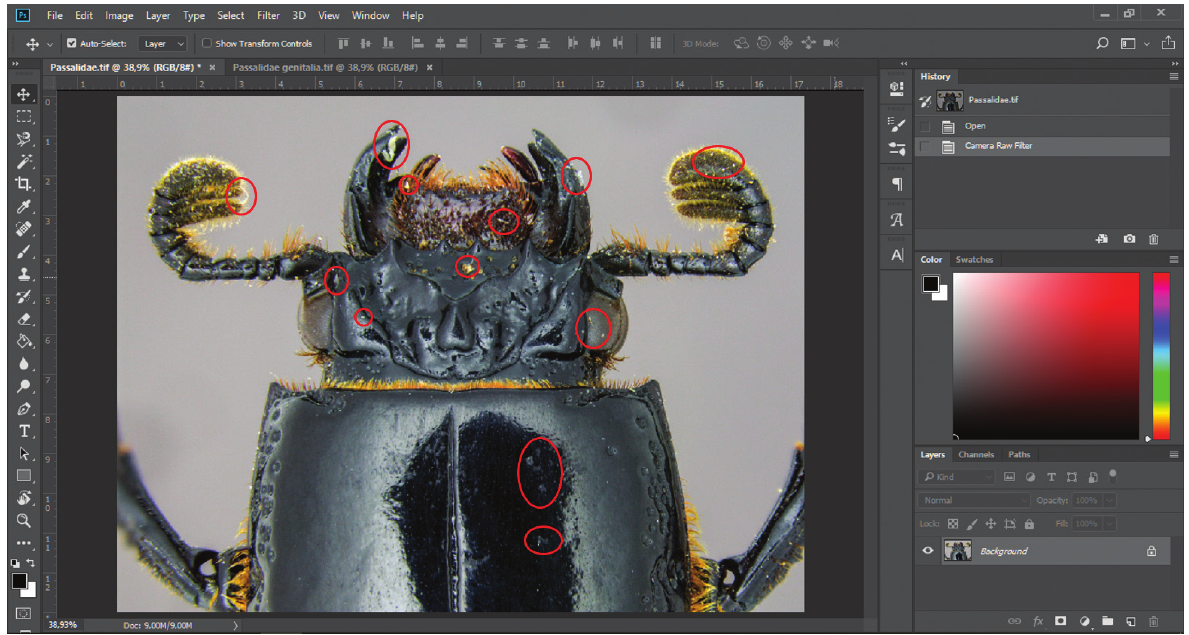
Figure 10. Unwanted elements in the image with highlighted dust particles, remnants from the insect collection and shadow